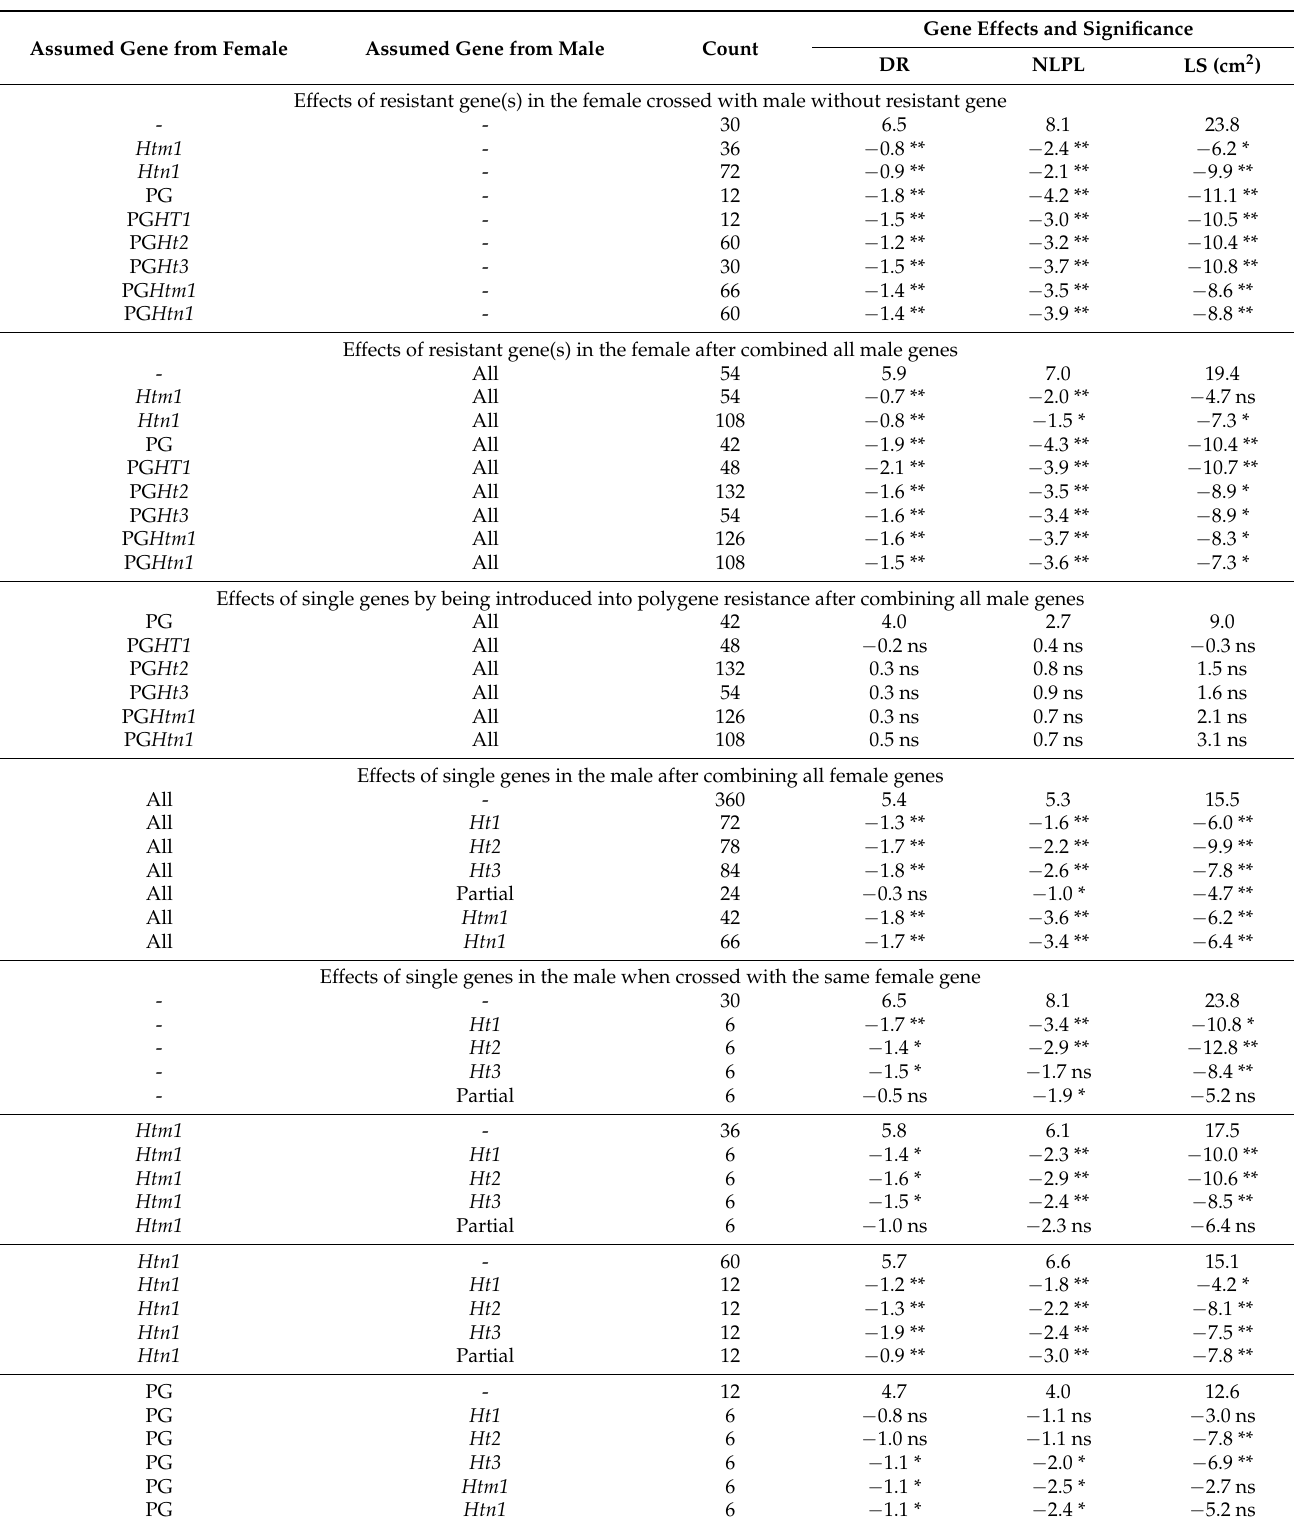
Table 2. Resistant gene effects on disease rating (DR), number of lesions per leaf (NLPL), and lesion size (LS, cm 2 ) of northern corn leaf blight compared with same female or male gene or combined all female or all male gene